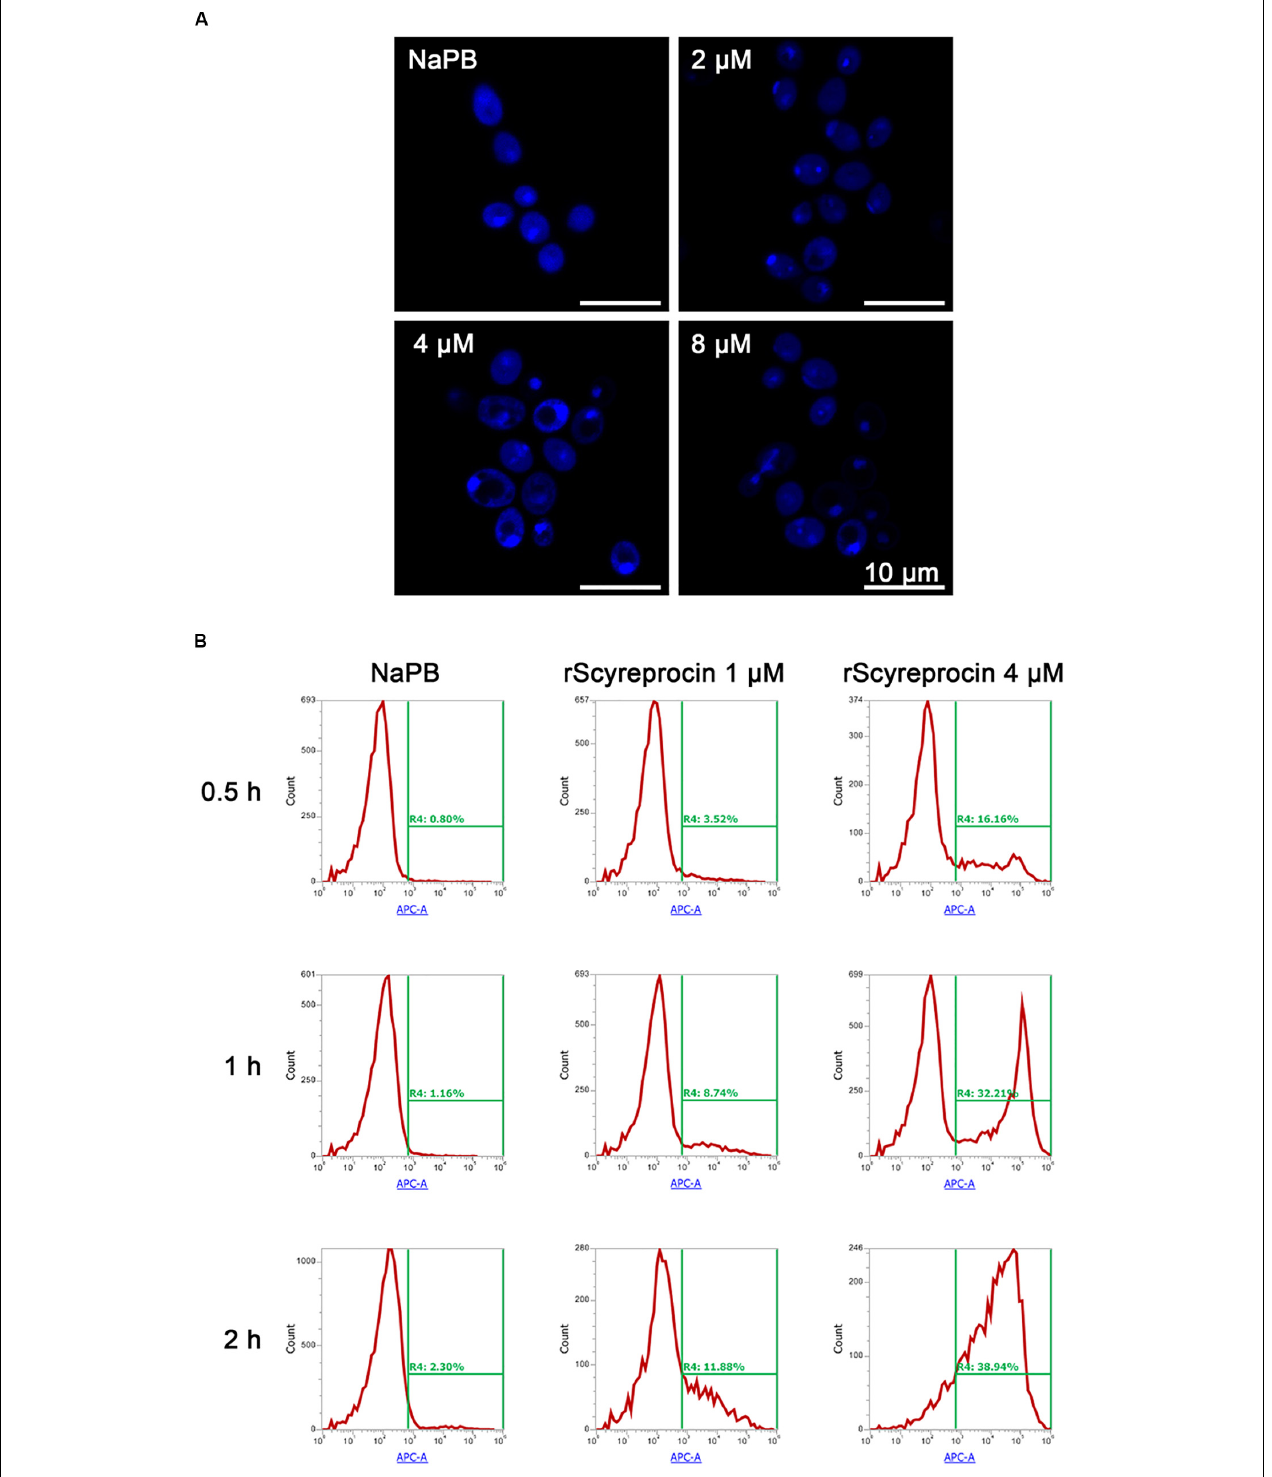
FIGURE 6 | Apoptotic effect of rScyreprocin on Candida albicans . (A) Exponential phase microbial cells of C. albicans were resuspended in culture media supplemented with NaPB (control) or rScyreprocin for 1 h at 28 ◦ C. Samples were then applied for 4 (cid:48) , 6-diamidino-2-phenylindole staining and observed for nucleus changes by a confocal scanning laser microscopy. (B) Exponential phase microbial cells of C. albicans were resuspended in culture media supplemented with NaPB (control) or rScyreprocin (1 and 4 µ M) at 28 ◦ C for various time period (0.5, 1, and 2 h). Samples were then processed for flow cytometry analysis of apoptosis using Annexin